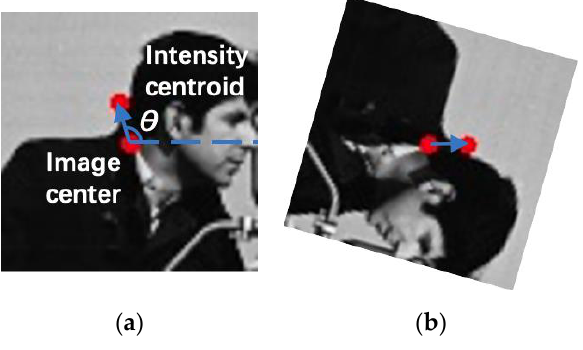
Figure 6. ( a ) Orientation representation estimation with intensity centroid and ( b ) orientation normalization to horizontal.